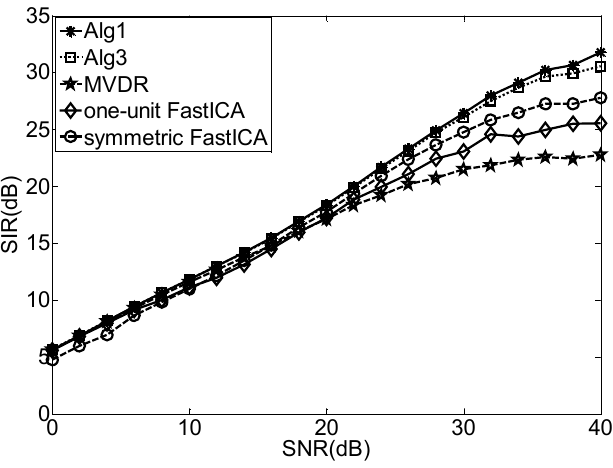
Figure 1. Comparison of the performance by using the algorithm of the Alg 1, Alg 3, MVDR, one-unit FastICA and symmetric